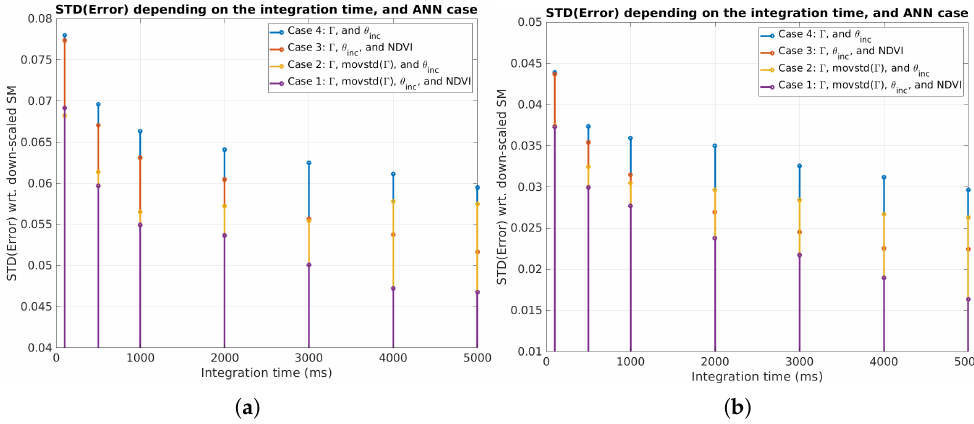
Figure 16. Standard deviation of the error of the ANN with respect to Sentinel-2/SMOS downscaled soil moisture for the four different cases for different integration times, at ( a ) L1 and ( b )